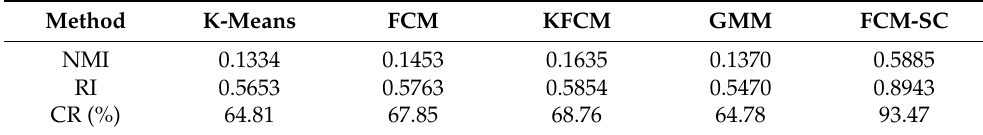
Table 2. Performance of different clustering algorithms on hyperspectral data (spectral and image features).